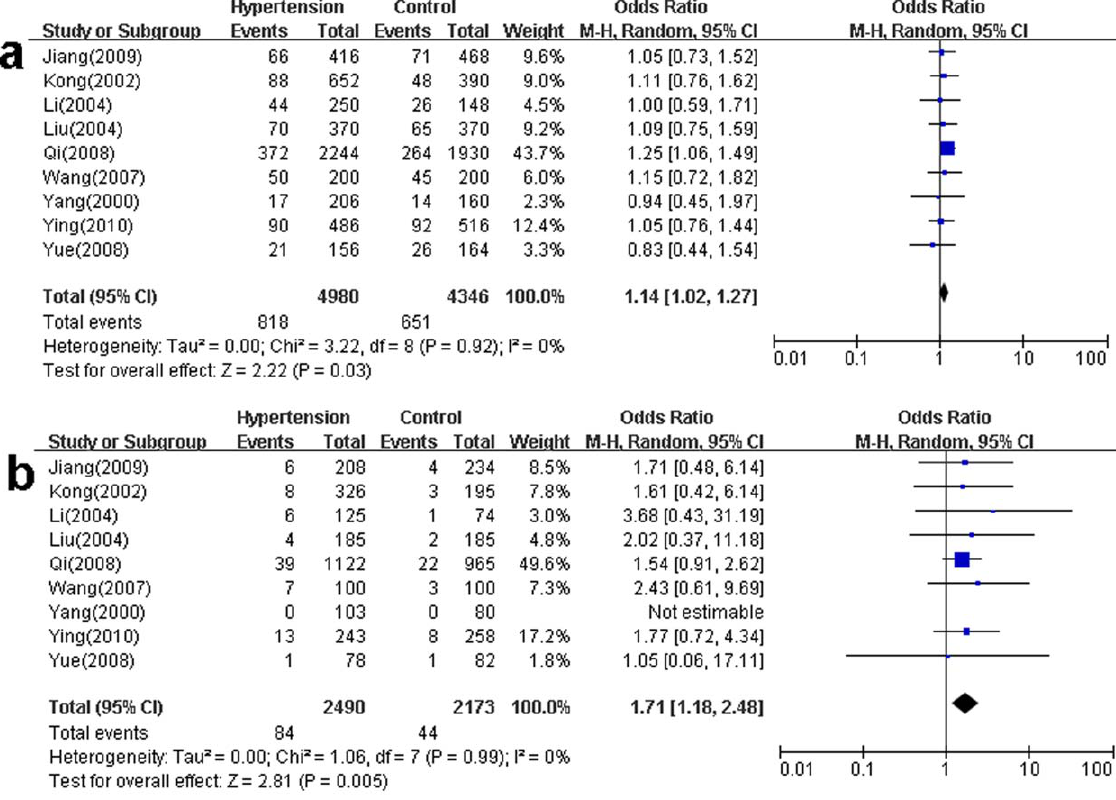
Figure 4. Meta-analysis for the overall association between the A-20C polymorphism and hypertension under various genetic contrasts. Figure 4a shows that the C allele carrier can increase the risk of hypertension compared to the A allele carrier. Figure 4b shows that the homozygous CC genotype carriers can increase the risk of hypertension compared to the A allele carrier (CA + AA).